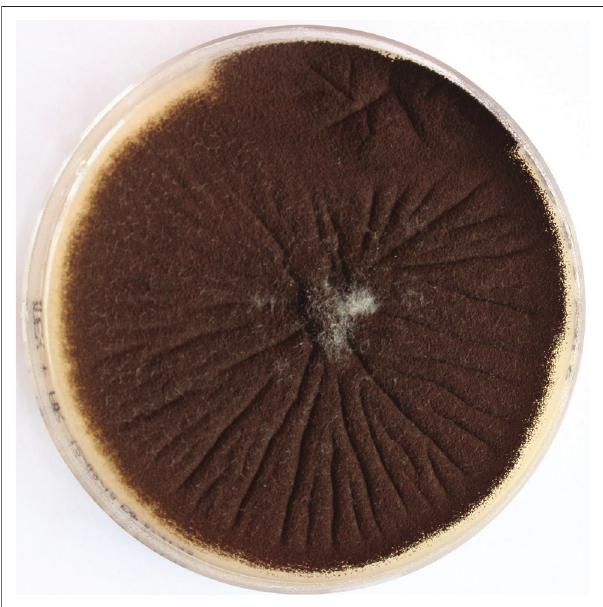
FIGURE 1: Characteristic black sporing heads of Aspergillus niger covering white mycelium macroscopically, grown at 35° C on Sabouraud Dextrose media with amikacin.